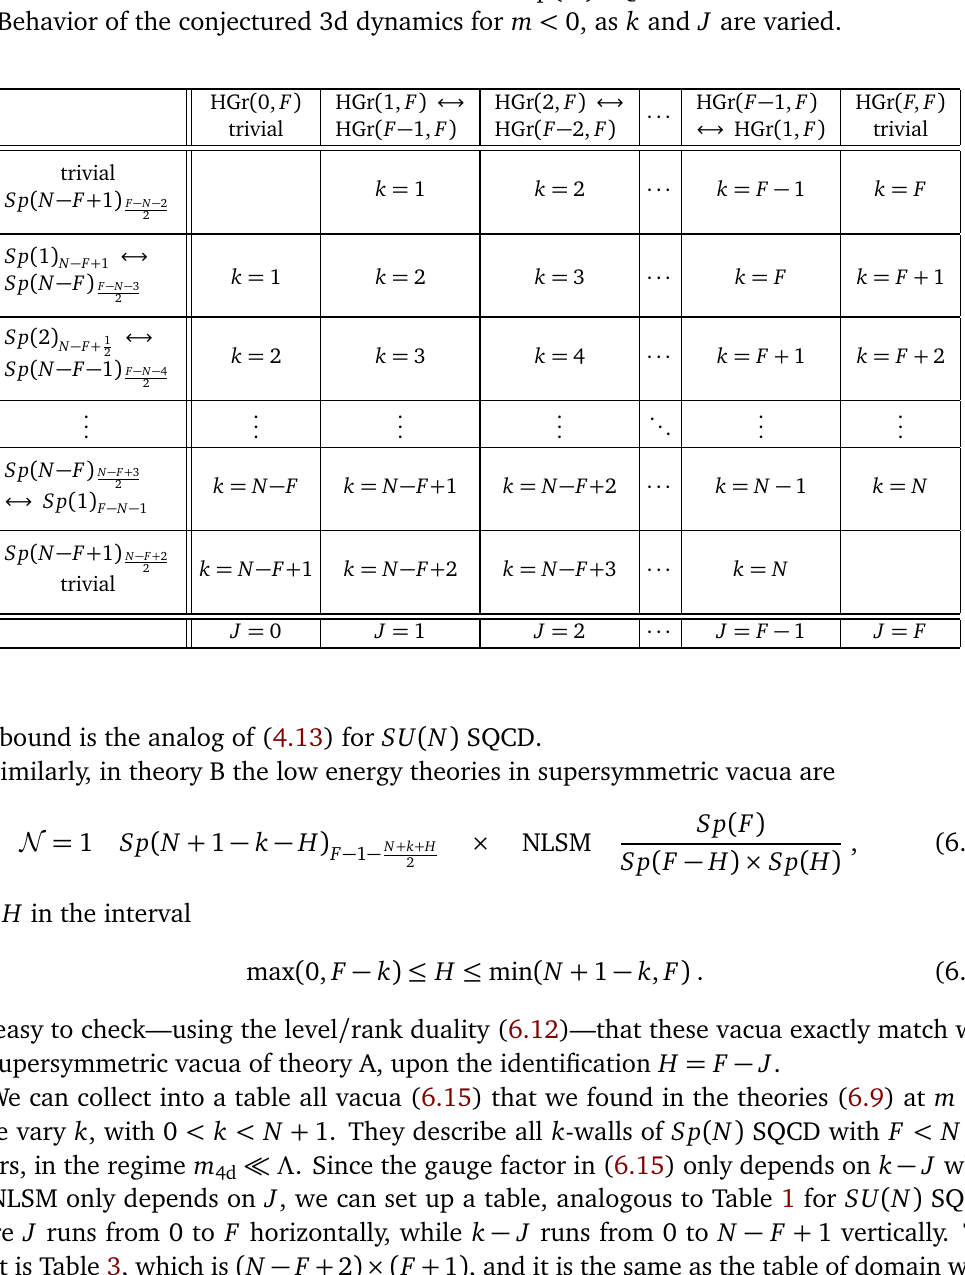
Table 3: Domain walls of massive 4 d